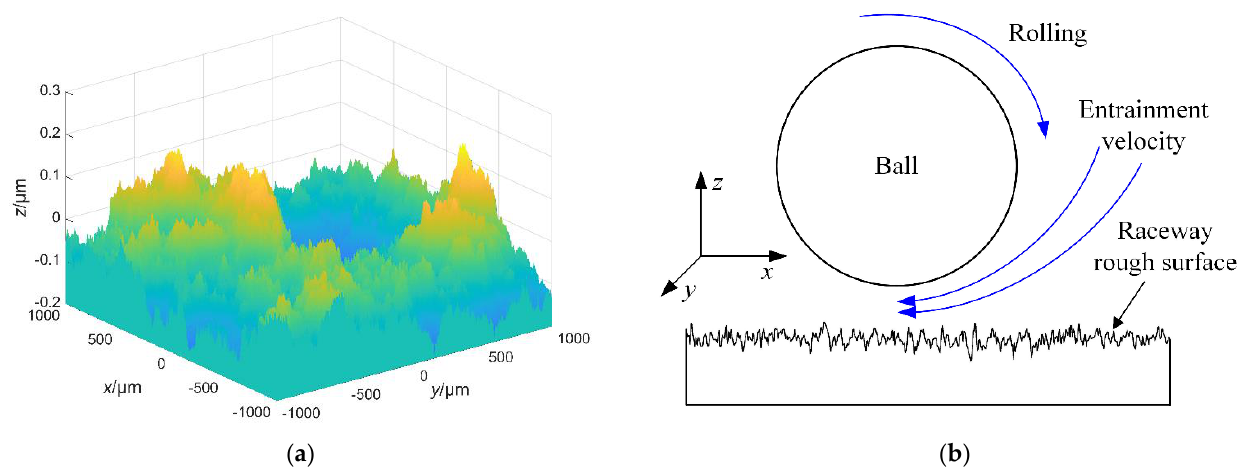
Figure 4. Diagram of the elastohydrodynamic contact mechanics. ( a ) The fractal rough surface. ( b ) Elastohydrodynamic contact mechanics. In terms of the elastohydrodynamic lubrication theory [25], the film thickness distri- bution is expressed as